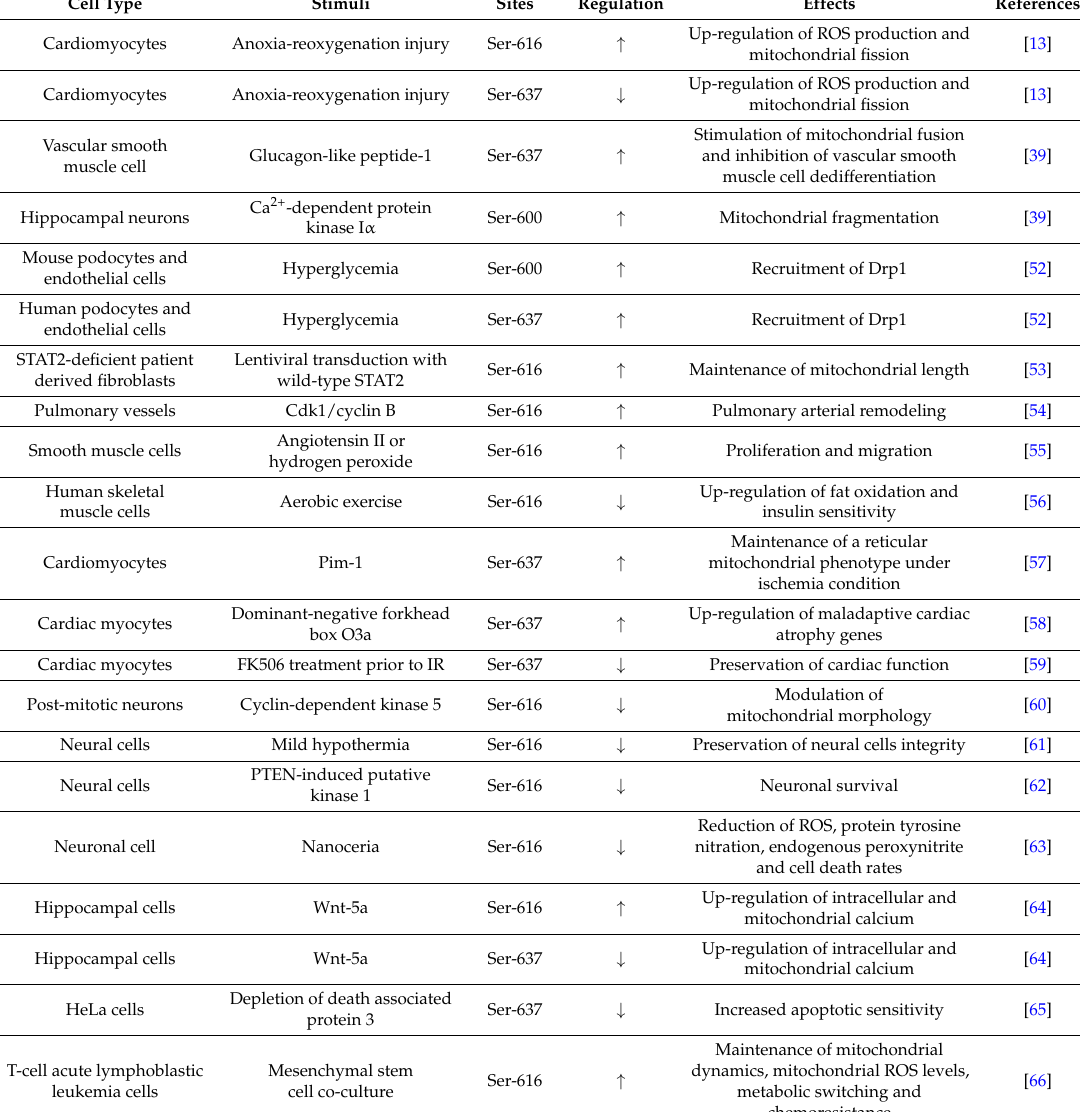
Table 1. Phosphorylated dynamin-related protein 1 (Drp1) at different sites and the correlated regulative ways for mitochondrial fission in mammals in vivo and in